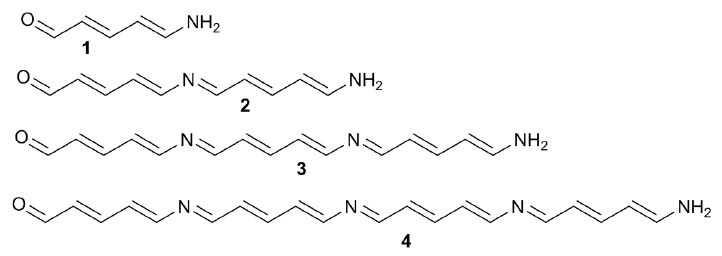
Chart 1. 1,6-Polyazaacetylene monomer ( 1 ) and respective oligomers ( 2 – 4 ): all-trans model struc-